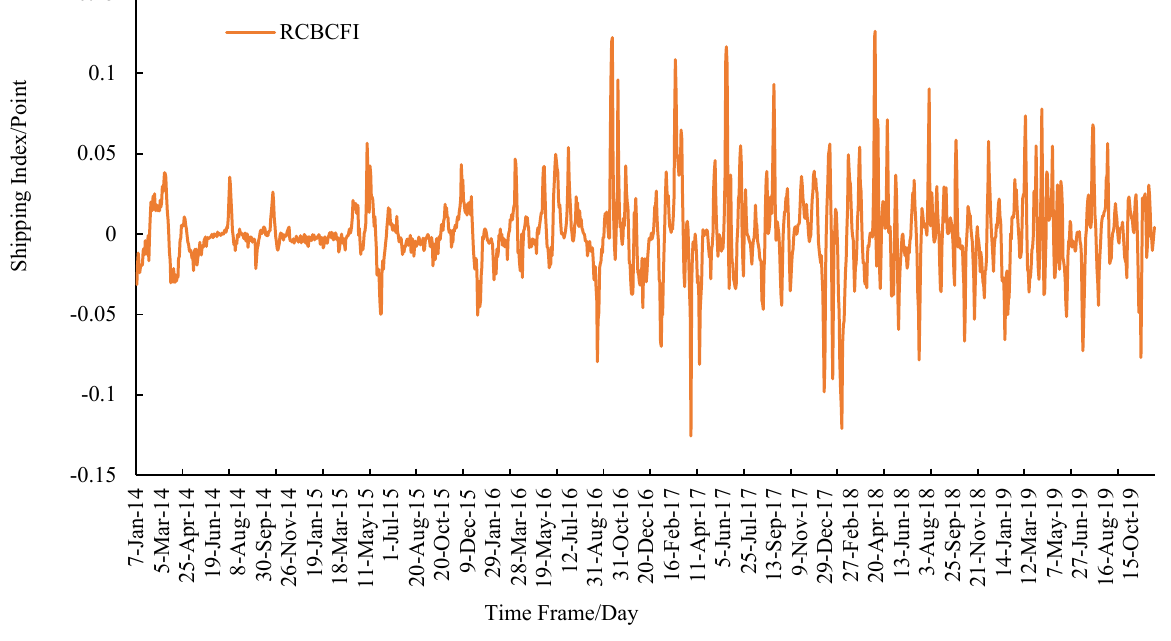
Figure 3. Historical data of CBFI return series.